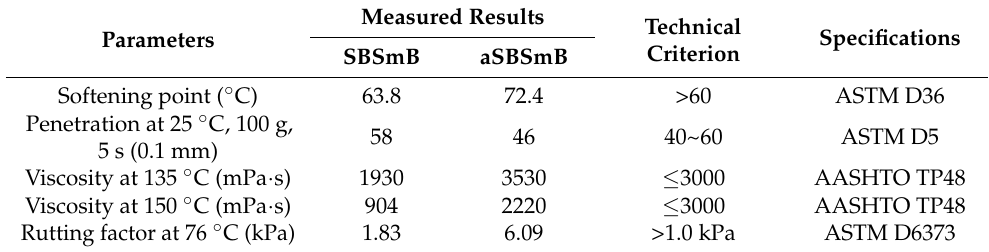
Table 1. Basic physical properties of SBS modified bitumen before and after aging.